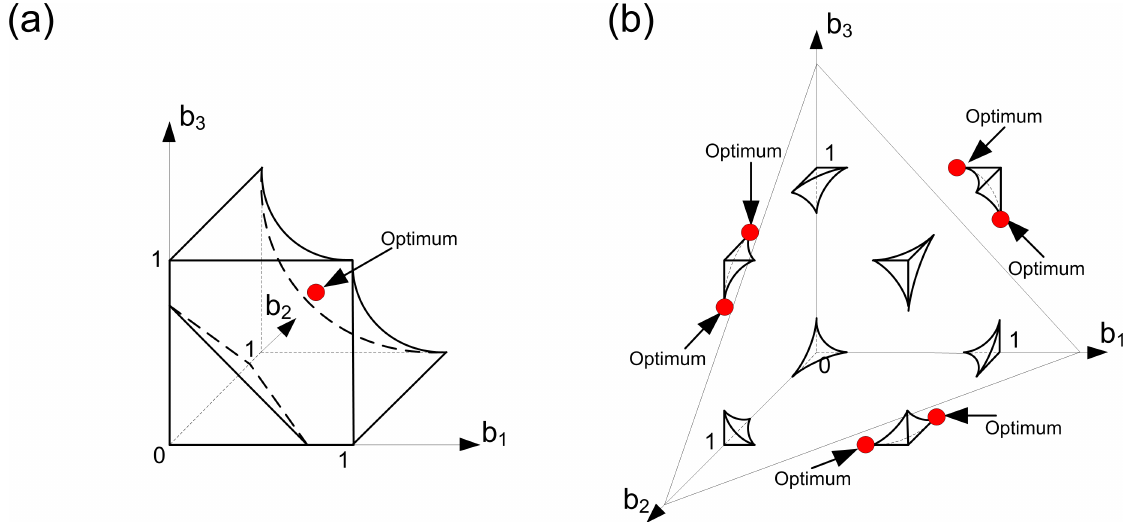
Fig 7. Evolution of germ and soma in colonies with identical cells: A concave trade-off, a resource constraint and different ‘importances’ of viability and fecundity (Case 3). Here we assume that we have three groups of cells within the colony such that all cells from each group have the same level of fecundity and the same level of viability (i.e., we have three ‘aggregate’ cells in the colony). Optimal strategies of the colony are colored in red. Unspecialized states (panel (a)) can be optimal as well as strategies with some level of specialization (panel (b)). Significant resource constraint (panel (b)) is one of the main reasons for the emergence of specialization in small-sized colonies. In both panels, α = 1, φ = 1- b 2 and k 2 = 1. In panel (a), β = 2, C = 5 and k 1 = 2. In panel (b), β = 1, C = 3.12 and k 1 = 1.